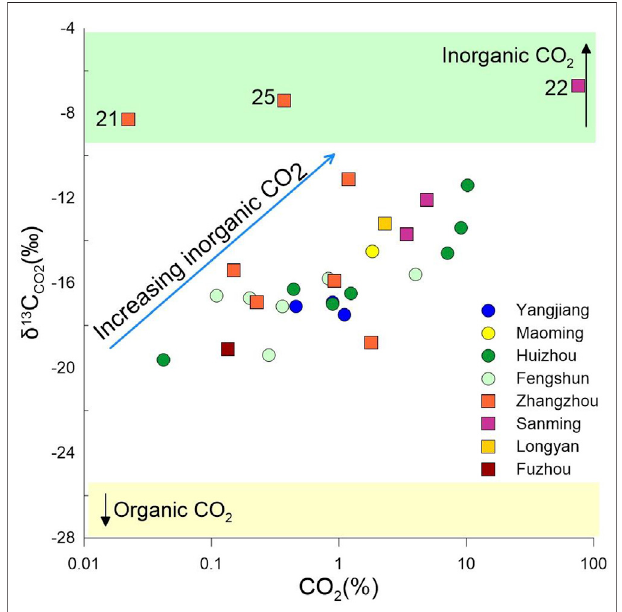
FIGURE 5 | δ 13 C ( ‰ ) versus CO 2 for hydrothermal volatiles from Southeast